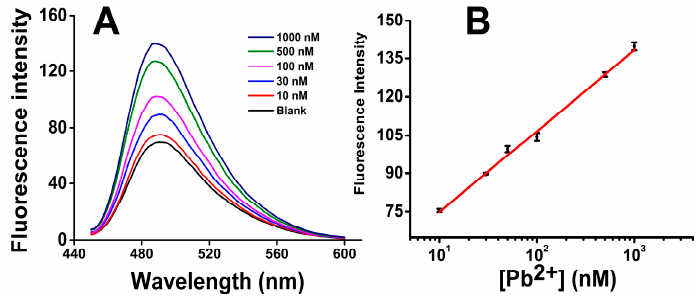
Figure 5. Quantification results of Pb 2+ : ( A ) The fluorescence spectra of ThT/G-quadruplex in the presence of Pb 2+ from 10 to 1000 nM; ( B ) Plot for the concentration of Pb 2+ vs. fluorescence signal gain. Error bars show the standard deviations of measurements taken from independent experiments with at least three distinct sensors.